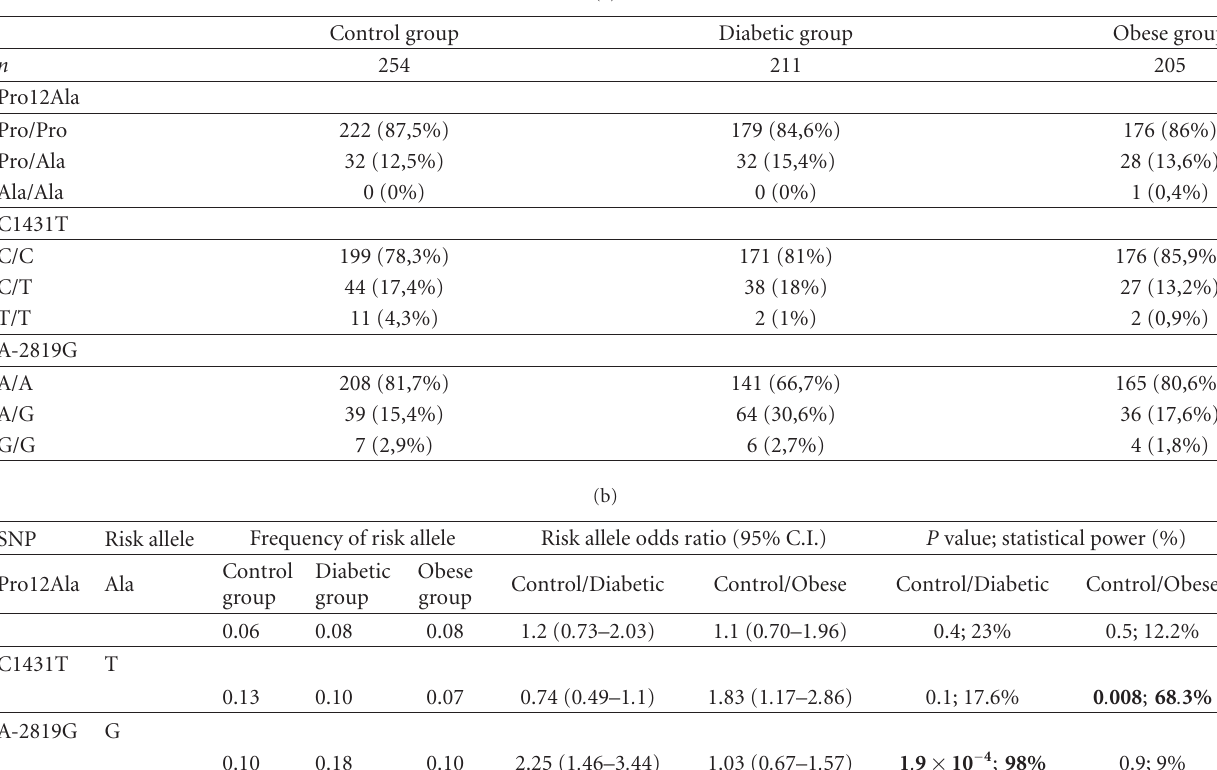
Table 2: Genotypes and allele frequencies in diabetic, obese, and control groups (statistical significant values are in bold).